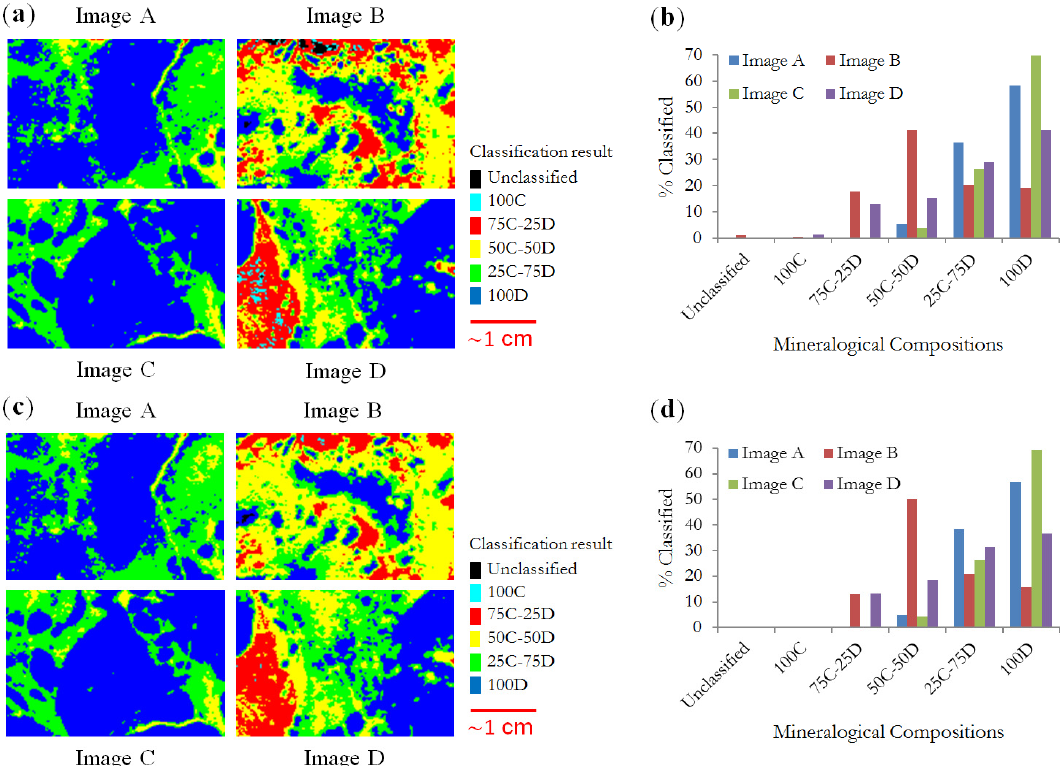
Figure 8. LSU classification results: ( a ) unconstrained dolomite endmember images, ( b ) estimated proportion of classified minerals derived from the unconstrained images, ( c ) constrained dolomite endmember images using a 1.0 default value of weight, and ( d ) estimated proportion of classified minerals derived from the constrained images. The classification images present a slight variability of carbonate fractional abundances in different unmixing approaches. (C = calcite and D = dolomite, prefix numbers showing the mineral contents in